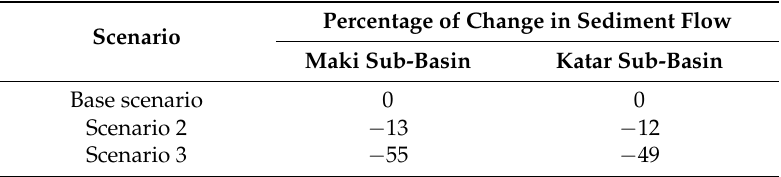
Table 3. Estimated sediment reduction due to conservation structures and best management practices as compared to the baseline